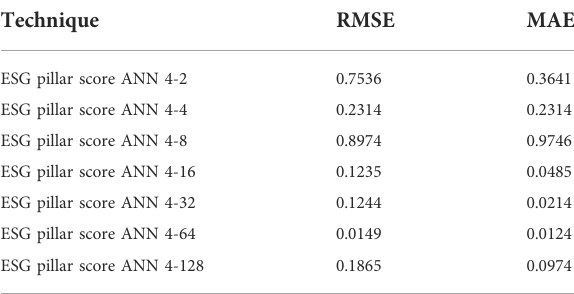
TABLE 9 Result of ESG pillar score error measurement using polynomial regression.